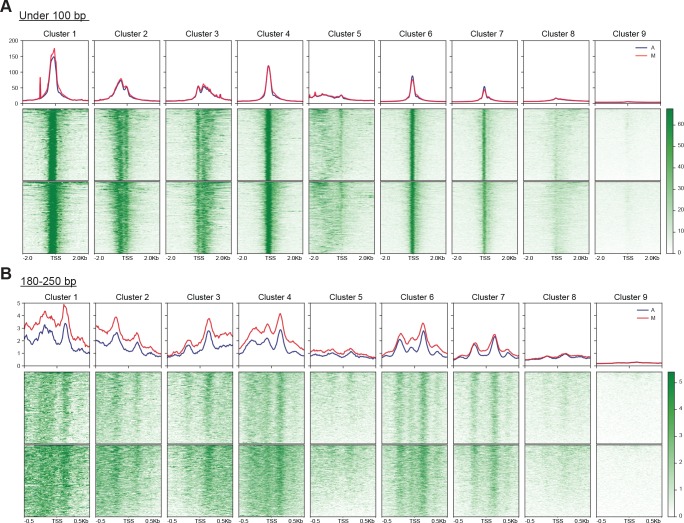
Accessibility at the TSS is maintained in mitosis.We performed unbiased k-means clustering of ATAC-seq data for reads under 100 bp (A) and 180–250 bp (B) with k = 9. The heatmaps for each cluster are shown on the bottom, and the average signal surrounding the TSS for each cluster is plotted on top.